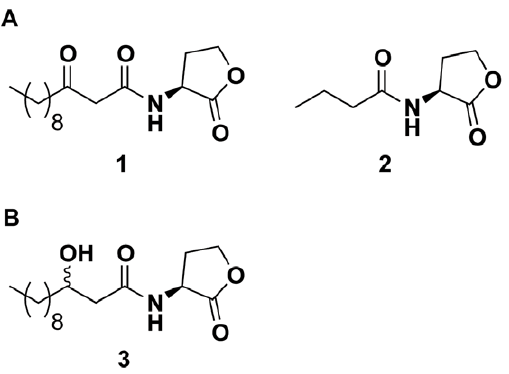
Figure 1. N -Acyl-homoserine lactone autoinducers. A, P. aeruginosa autoinducers. B, A. baumannii autoinducer.